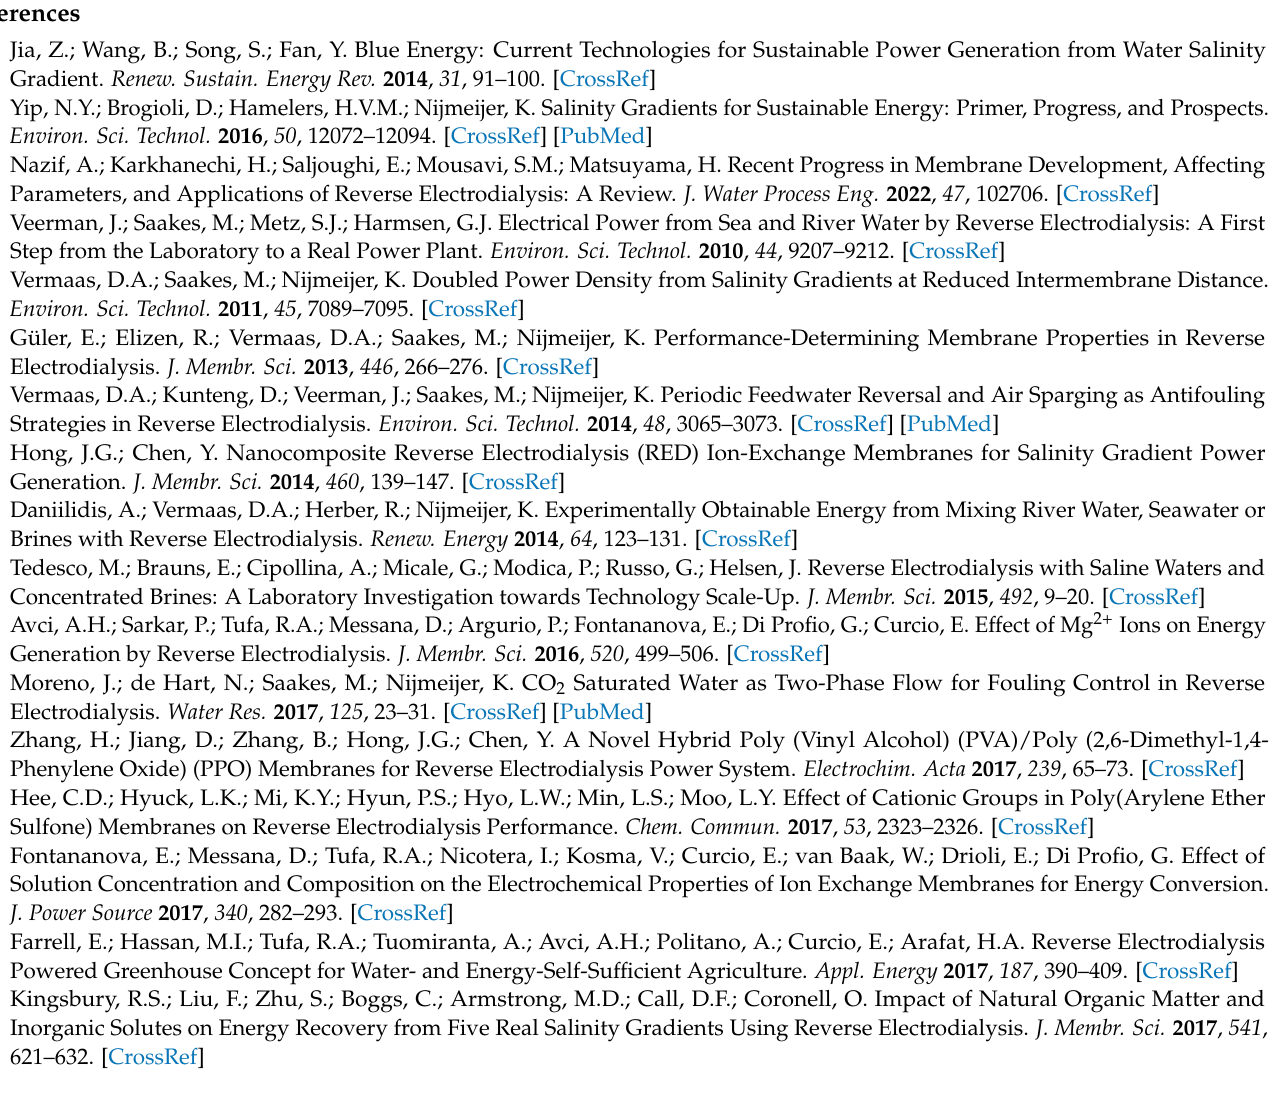
κ LS dependence of R int,cal using natural SW as HS and surface water as LS; Figure S10: Set up of electrode resistance measurement; Figure S11: V - I curves of the stack without IEMs before and after a series of power generation test using model SW and model RW; Figure S12: V - I curves of the stack without IEMs before and after a series of power generation test using model RO brine and model RW; Figure S13: V - I curves of the stack without IEMs before and after a series of power generation test using natural SW and surface water; Figure S14: Spacer net geometry. References [36,46] are cited in the Supplementary